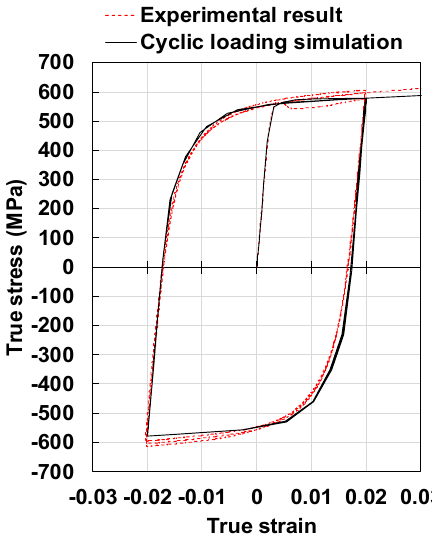
Figure 1. Adopted stress–strain curve in simulation.